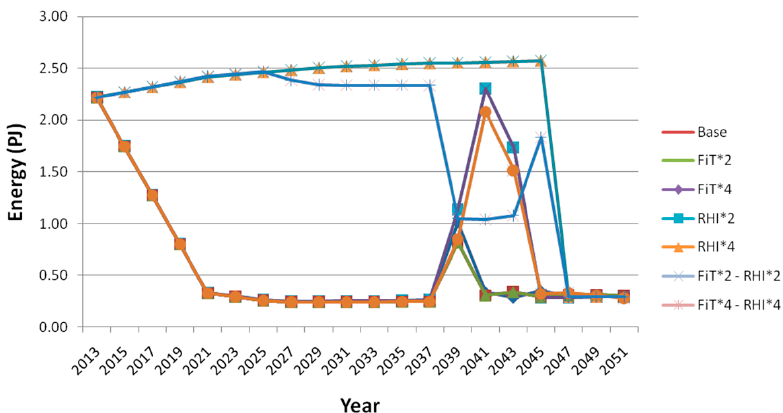
Figure 18. Specialist poultry farms—fuel consumption.